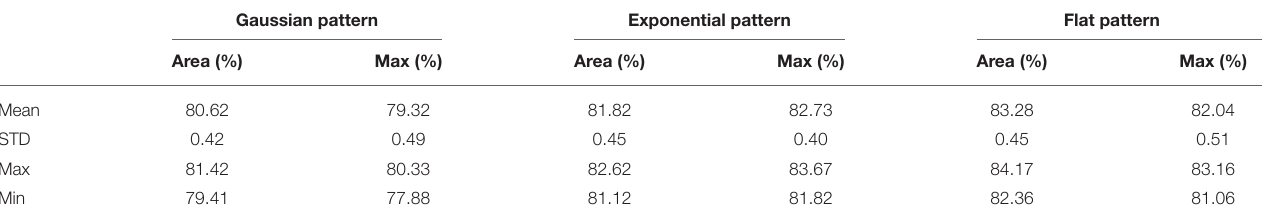
TABLE 3 | Mean accuracies and standard deviation for the comparison between the Exponential, Flat, and Gaussian training patterns.